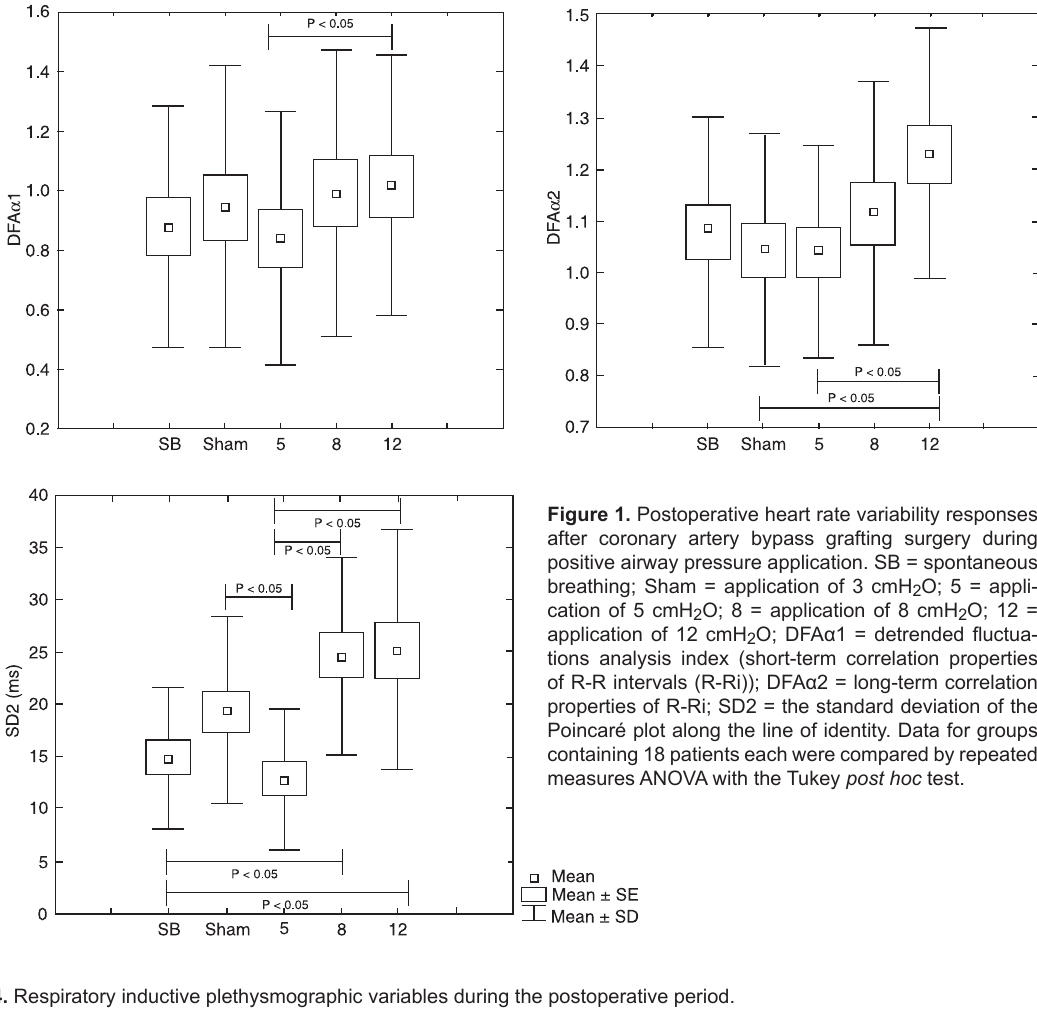
Table 4. Respiratory inductive plethysmographic variables during the postoperative period.